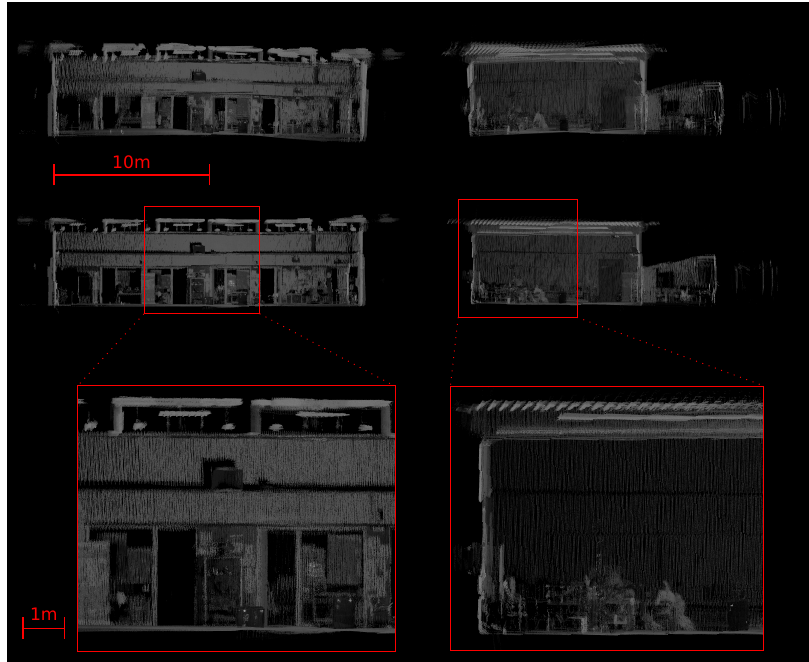
Figure 12. 3D view of Experiment 3 with trajectory. The structure of the scene improves, e.g., at the